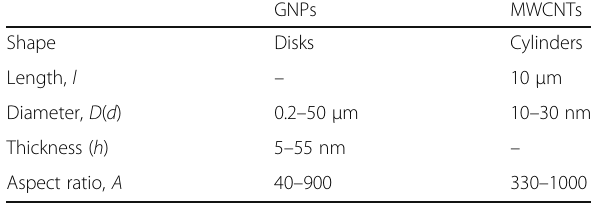
Table 1 Structural and morphological characteristics of fillers GNPs MWCNTs Shape Disks